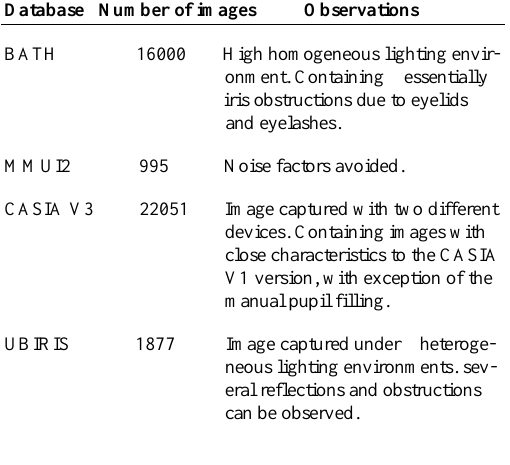
Table 1. Characteristics of the iris image databases .